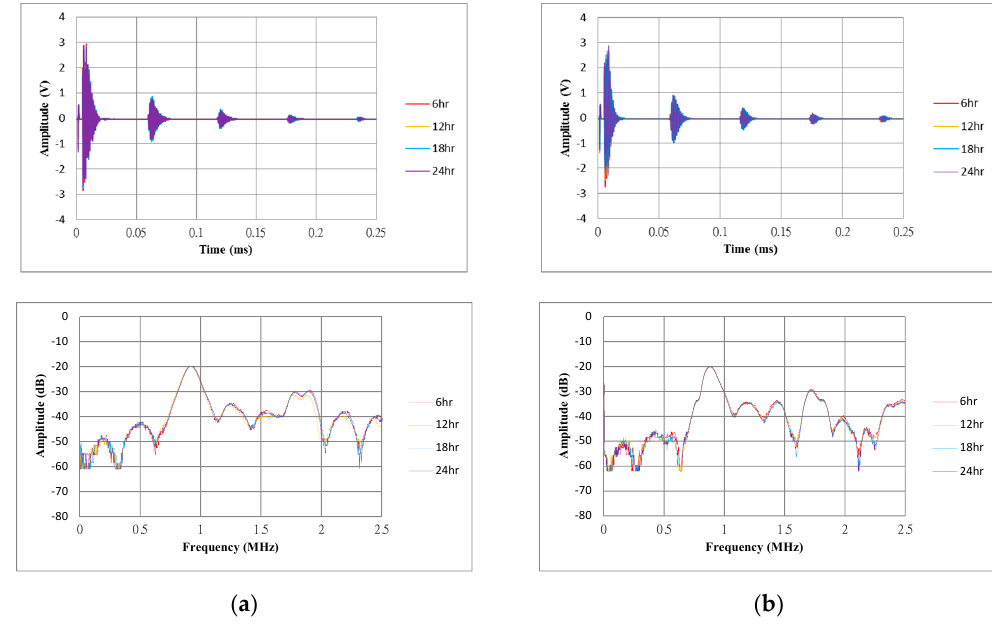
Figure 18. ( a ) Time and frequency responses of the CMUTs with gold electrodes; ( b ) Time and frequency responses of the CMUTs with silver nanowire electrodes.